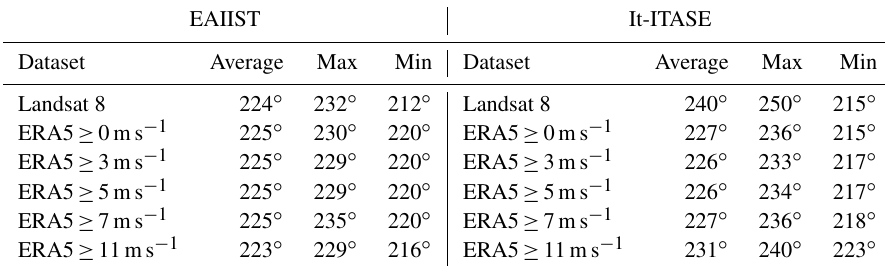
Table A3. Wind direction statistics (average, maximum and minimum values) for the considered datasets: Landsat 8 at 30m spatial resolution and ERA5 at 30km spatial resolution (divided into five sub-datasets according to wind speed) at the EAIIST and It-ITASE